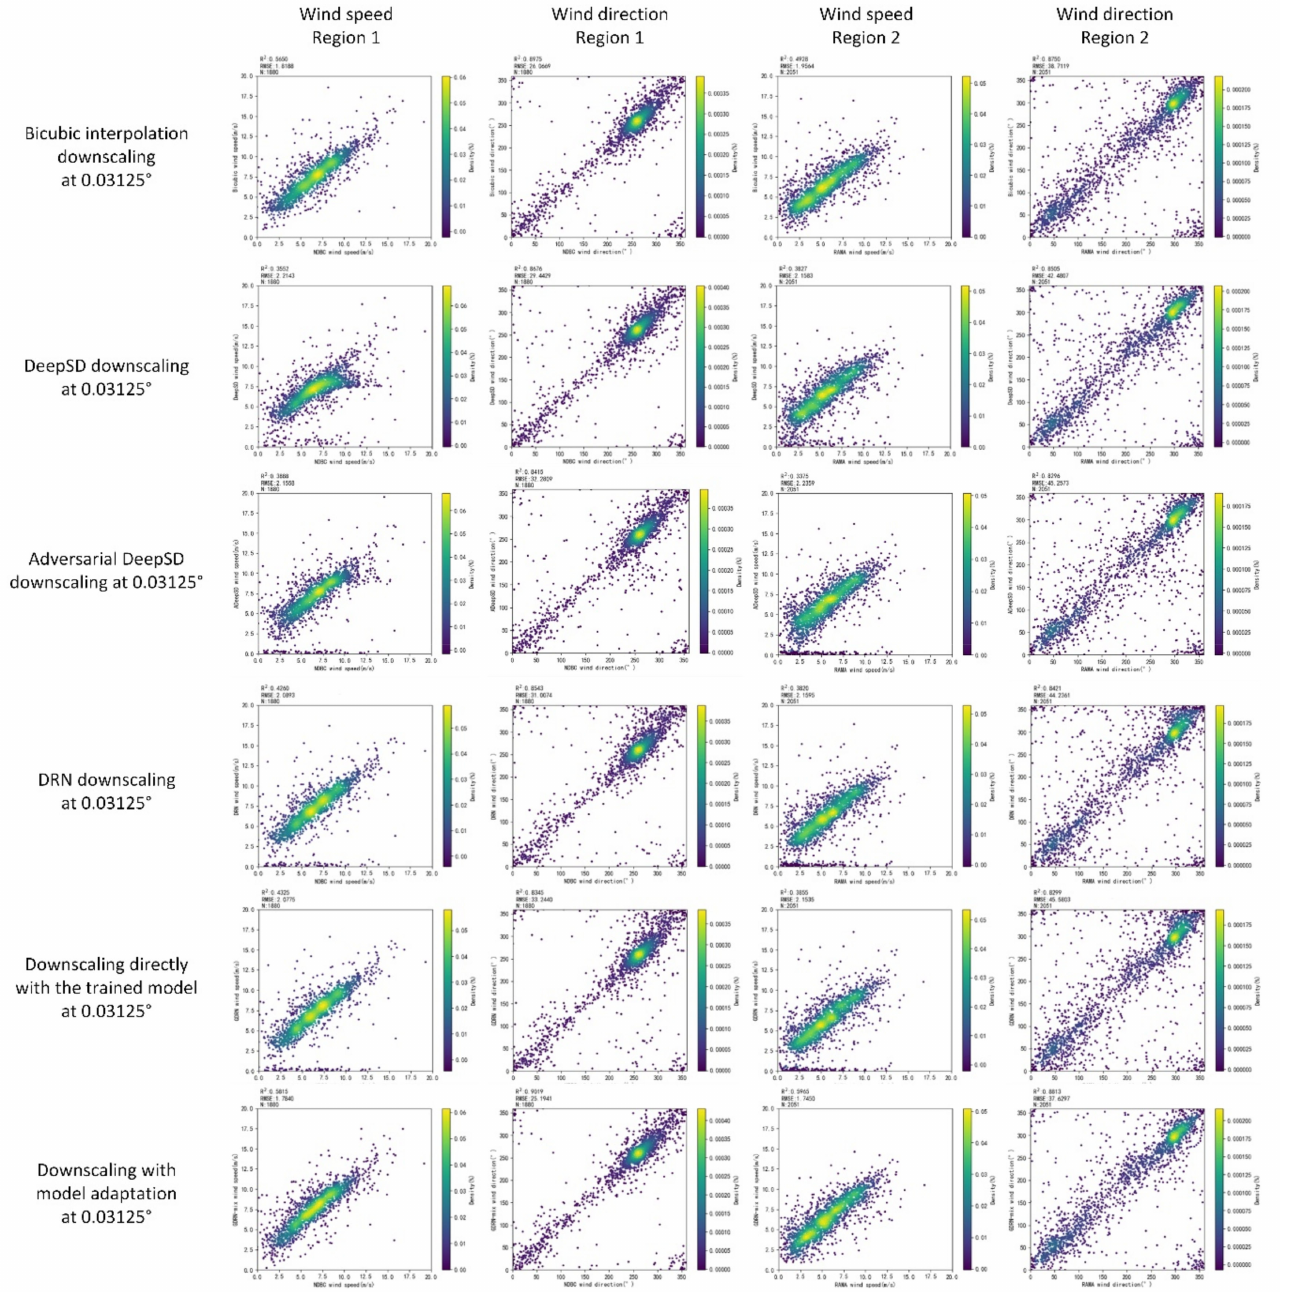
Figure 8. The validation results of sea surface wind with in situ buoy measurements for the 8 × downscaling reconstructed high-resolution results at 0.03125 ◦ on the test dataset. From left to right in each row, sub-images are for the wind speed and the wind direction in Region 1 and Region 2, respectively. From top to bottom, sub-images corresponds to the results for the bicubic interpolation downscaling, the DeepSD downscaling, the adversarial DeepSD downscaling, the DRN downscaling, the downscaling results directly by applying the proposed model trained with synthetic data, the downscaling results using a model adaptation by sampling both unpaired SSW and synthetic paired